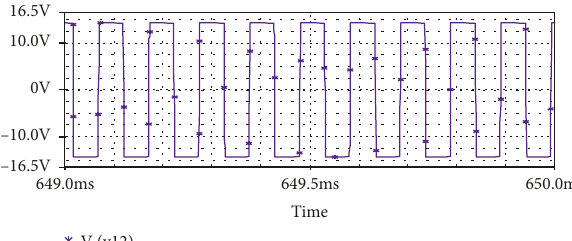
Figure 21: The wave form of square load torque with R � 5.05M Ω .